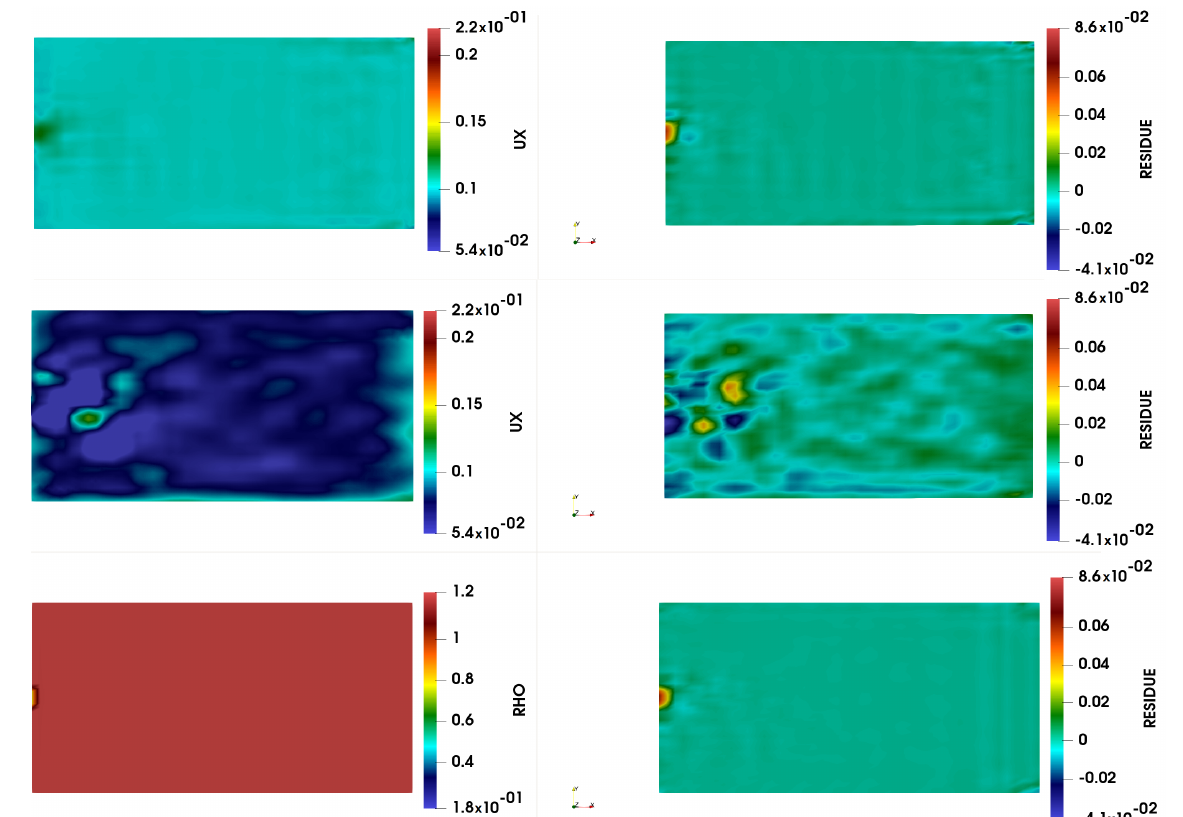
Figure 20. On the top left, the 32-th decoder generation µ h ( t ) ∼ p θ ( µ h ( t ) | z ) from a sample of the probability distribution p θ ( z ) for the data-targeted VAE. On the top right, the residue of this generated sample, ∂ρ h ( t 32 ) middle left, the 32-th decoder generation µ h ( t ) ∼ p θ ( µ h ( t ) | z ) from a sample of the probability distribution N ( 0,1 ) for the classical VAE. On the middle right, the residue of this generated sample, ∂ρ h left, the high-fidelity density field ρ h ( t 32 ) projected on the Cartesian mesh. On the bottom right, the accurate residue ∂ρ h ( t 32 ) + div ( ρ ( t ) u ( t )) 32 32 h h ∂ t